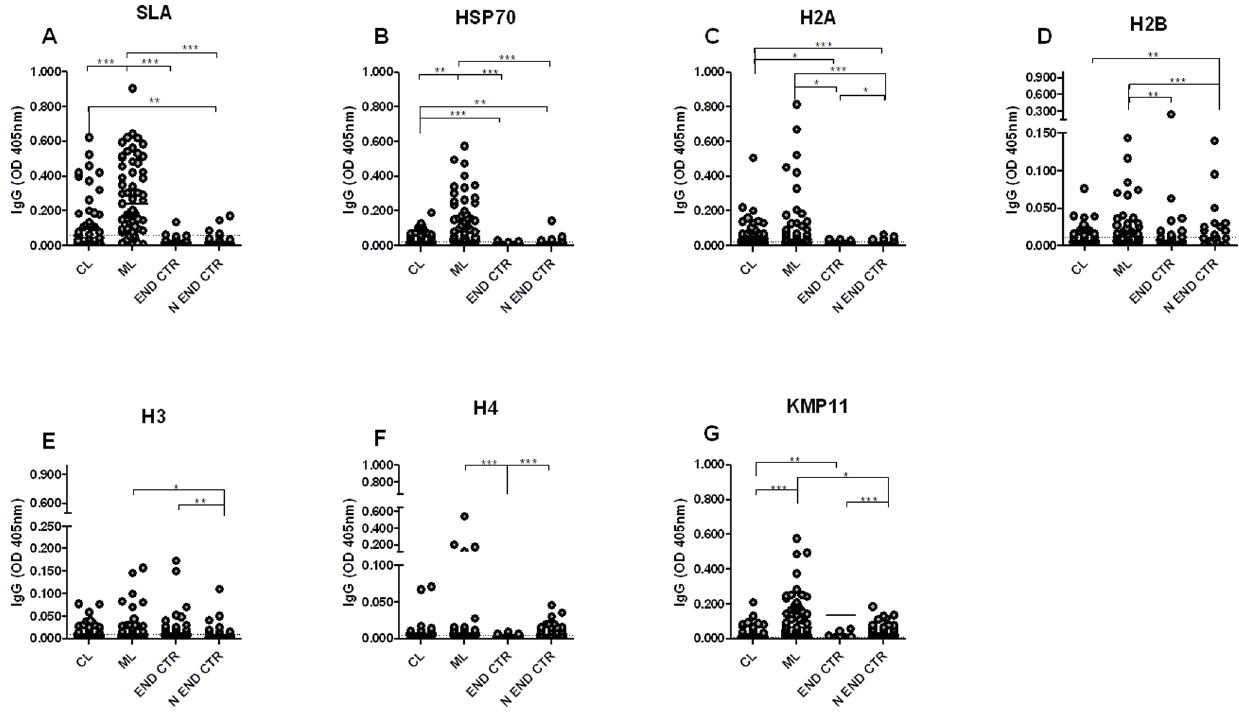
Figure 1. Anti- Leishmania IgG antibodies levels TL patients. Sera from mucosal Leishmania sis (ML) (n=53) and cutaneous Leishmania sis (CL) (n=49) patients, and sera from healthy individuals from endemic (n=39) and from non-endemic (n=49) areas were tested against SLA (A), rHSP70 (B), rH2A (C), rH2B (D), rH3 (E) rH4 (F) and rKMP11 antigens (G). The cut-off was calculated by comparison of the reactivity values from patient’s serum samples and from normal volunteers from endemic area and non-endemic areas. The cut-off value for negative and positive samples is indicated in dotted line. The solid lines represent the median values. Each point represents the mean of the duplicate OD values for the same serum with a standard deviation lower than 20%. Significance was compared using Kruskal-Wallis test with Dunn’s post test for multiple comparisons. * p , 0.05, ** p , 0.001 **, p , 0.0001.